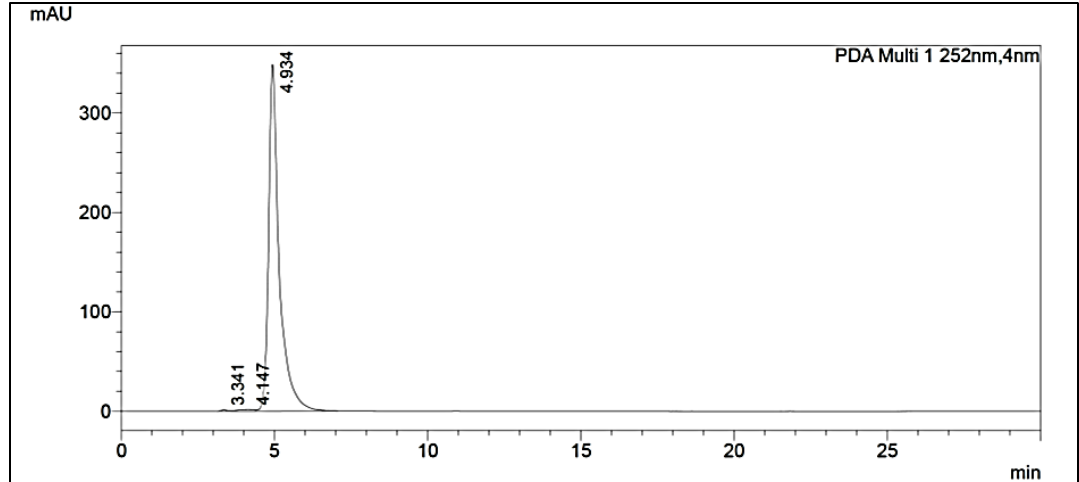
Figure 7. The UHPLC (Ultra High-Performance Liquid Chromatography) chromatogram of BDCe fraction isolated from Obea of O. bracteata.